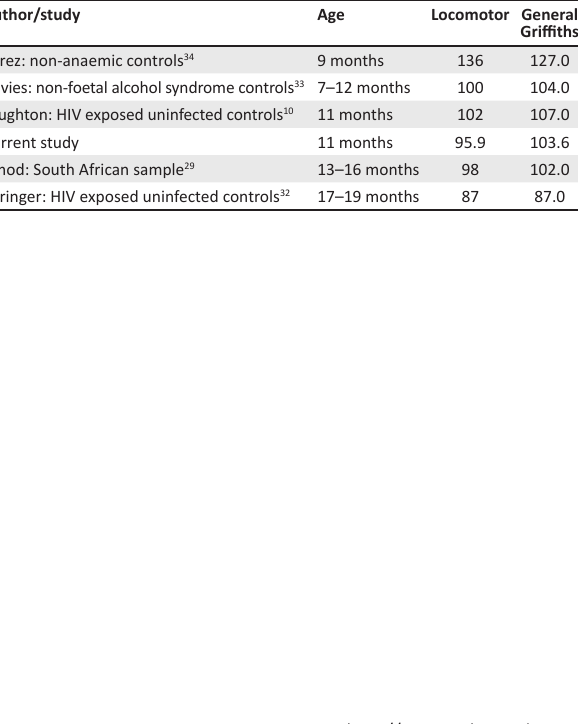
TABLE 3-A1: Summary of scores on the Griffiths mental development scales locomotor and General Griffiths from controls on South African studies at similar